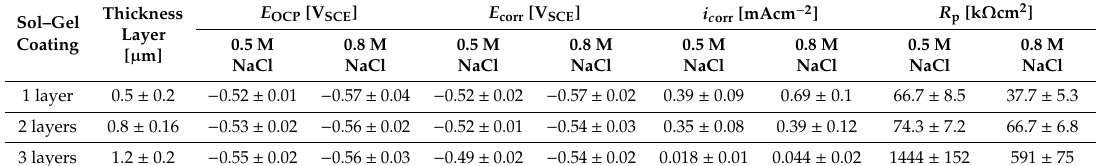
Table 2. Thickness and electrochemical parameters of sol–gel coatings (mean values).